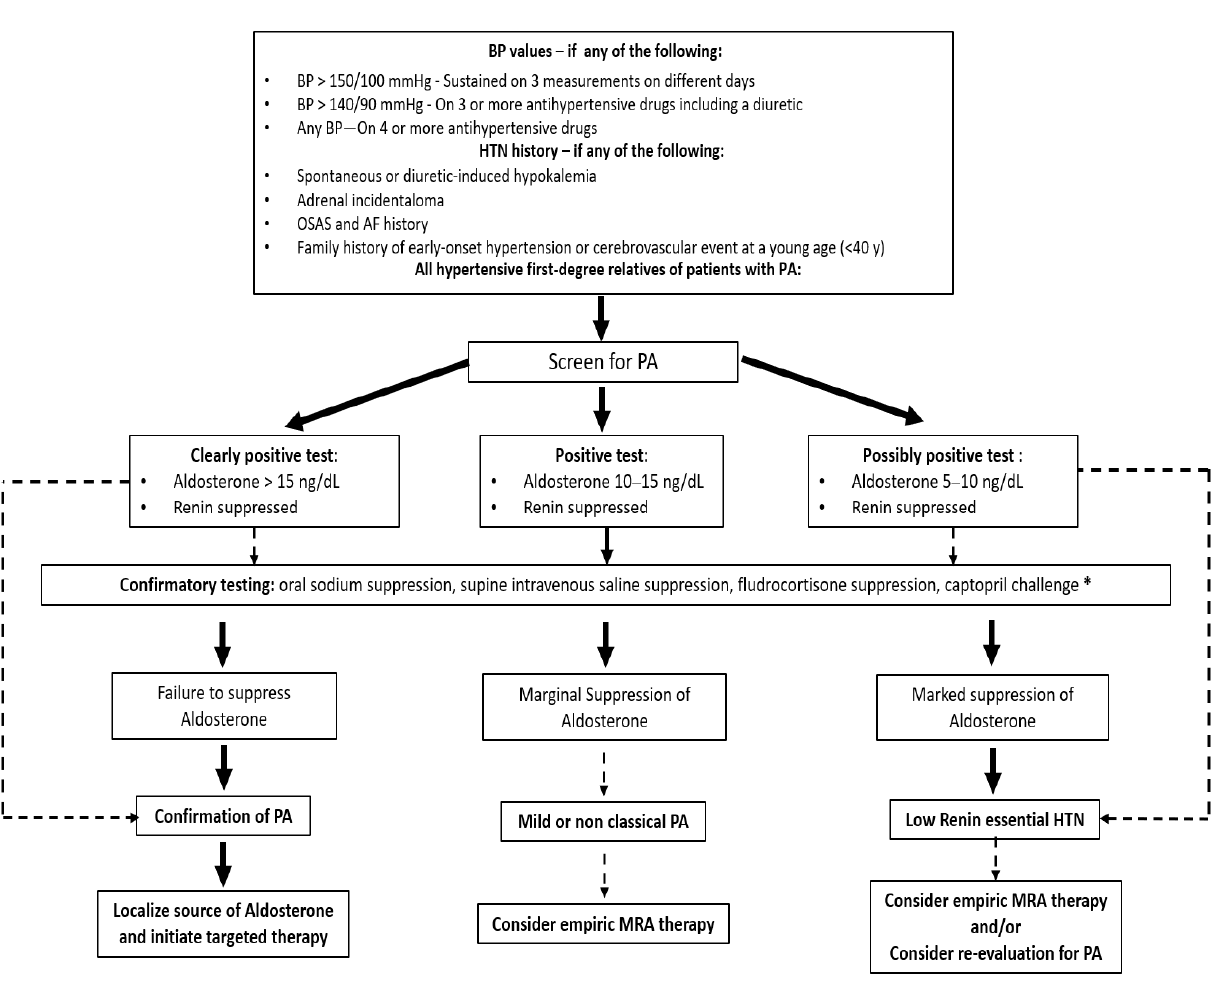
Figure 2. Screening and diagnostic approach for primary aldosteronism. A positive screen for primary aldosteronism should suggest high aldosterone levels and a suppressed renin activity. Confirmatory testing can be used in this setting. Solid arrows indicate recommended decision pathways; dashed arrows indicate other possible diagnostic alternatives in appropriate clinical contexts. * Confirmatory testing suggesting aldosterone hypersecretion: (1) oral sodium suppression (positive if 24 h urinary aldosterone excretion rate is greater than 12–14 mg/die); (2) supine intravenous saline suppression (positive if aldosterone levels are greater than 10 ng/dL after 2 L of saline infusion); (3) fludrocortisone suppression (positive if seated aldosterone greater than 6 ng/dL with plasma renin activity lower than 1.0 ng/mL/h); and, finally, (4) captopril challenge (positive if less than 30% suppression of aldosterone from baseline while plasma renin activity remains suppressed post 25 mg of oral captopril). AF, atrial fibrillation; BP, blood pressure; HTN, hypertension; MRA, mineralcorticoid-receptor antagonists; OSAS, obstructive sleep apnea syndrome; PA, primary aldosteronism. (Modified and adapted from document of The Endocrine Society [101]).